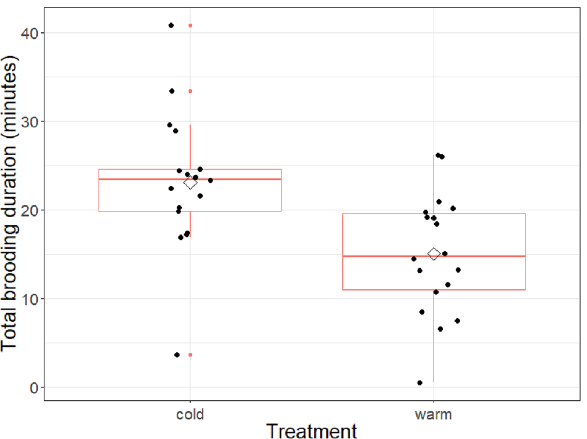
Figure 1. Difference in total amount of time spent brooding by the female, separated by treatment. Boxplot distribution (red), mean (diamond) and data points (black) are presented and represent the time a female is brooding within one-hour of treatment in either warm or cold conditions. Mean ± SE of cold treatment: 23 ± 2 min; warm treatment: 15 ± 1.6 min.